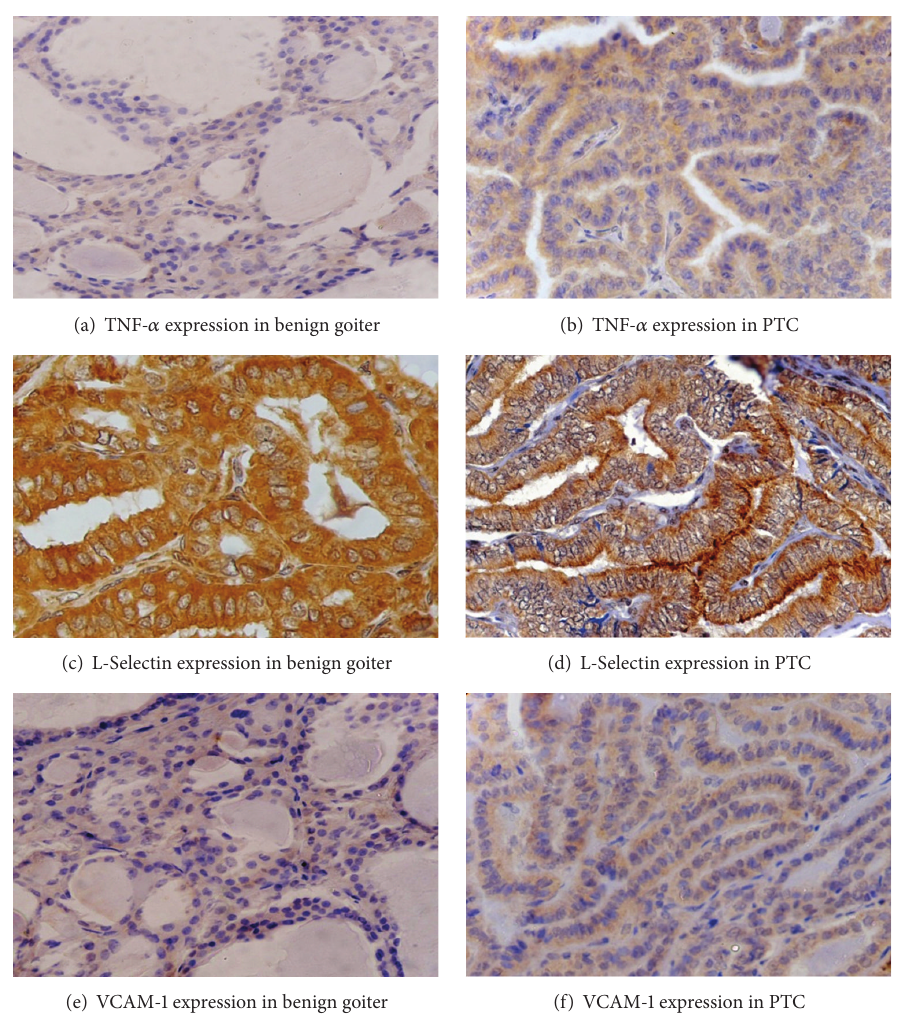
Figure 4: Representative staining patterns of the protein expressions of TNF- 𝛼 , L-Selectin, and VCAM-1 in primary tumours of patients with benign thyroid diseases and PTC.